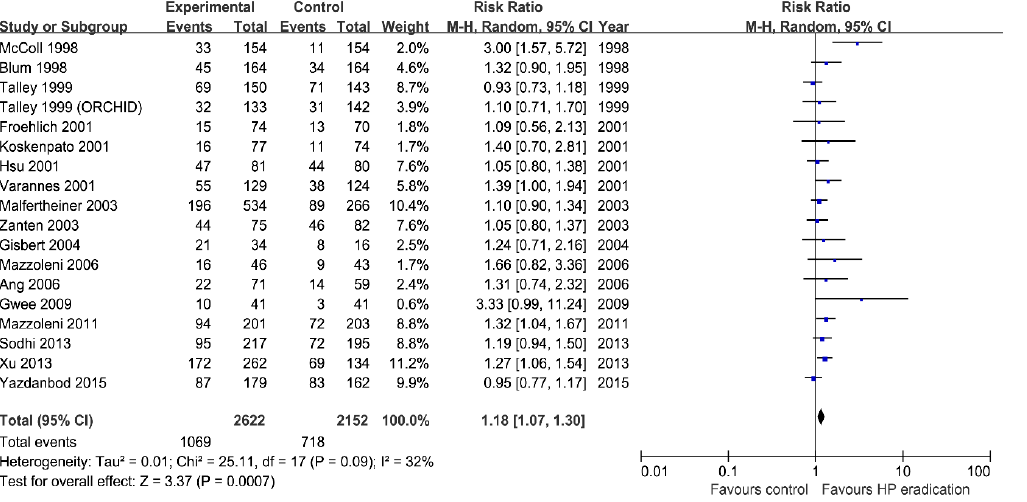
Figure 2. Forest plot for the effect of Helicobacter pylori eradication on the improvement of symptoms in patients with functional dyspepsia by random-effects analysis. CI: confidence interval.